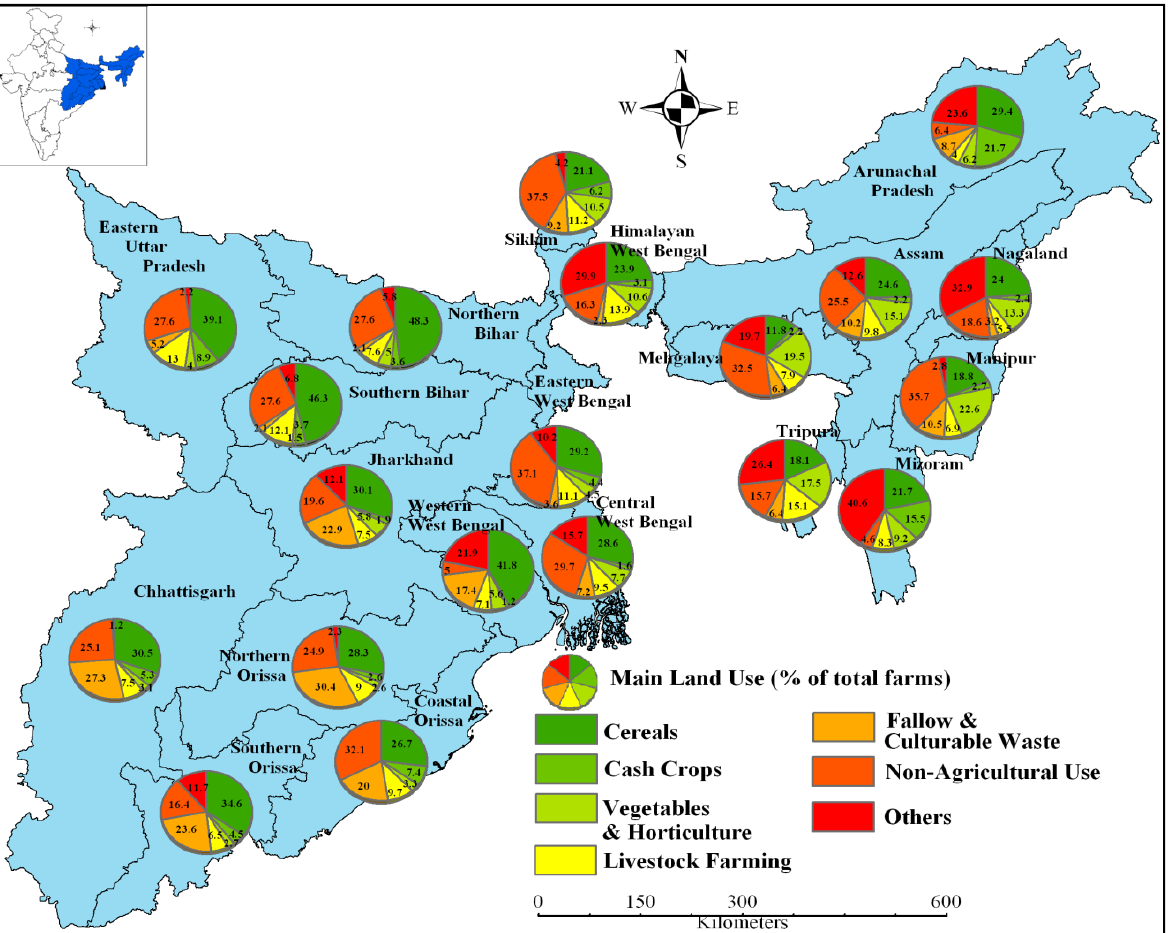
Note: Estimates calculated by authors using 59th Round NSS